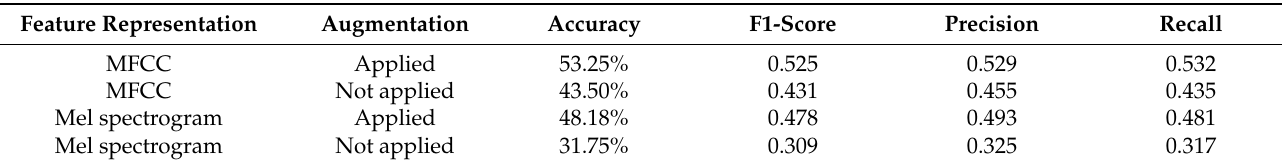
Table 7. Results of ML-based classification of ESC50 dataset.